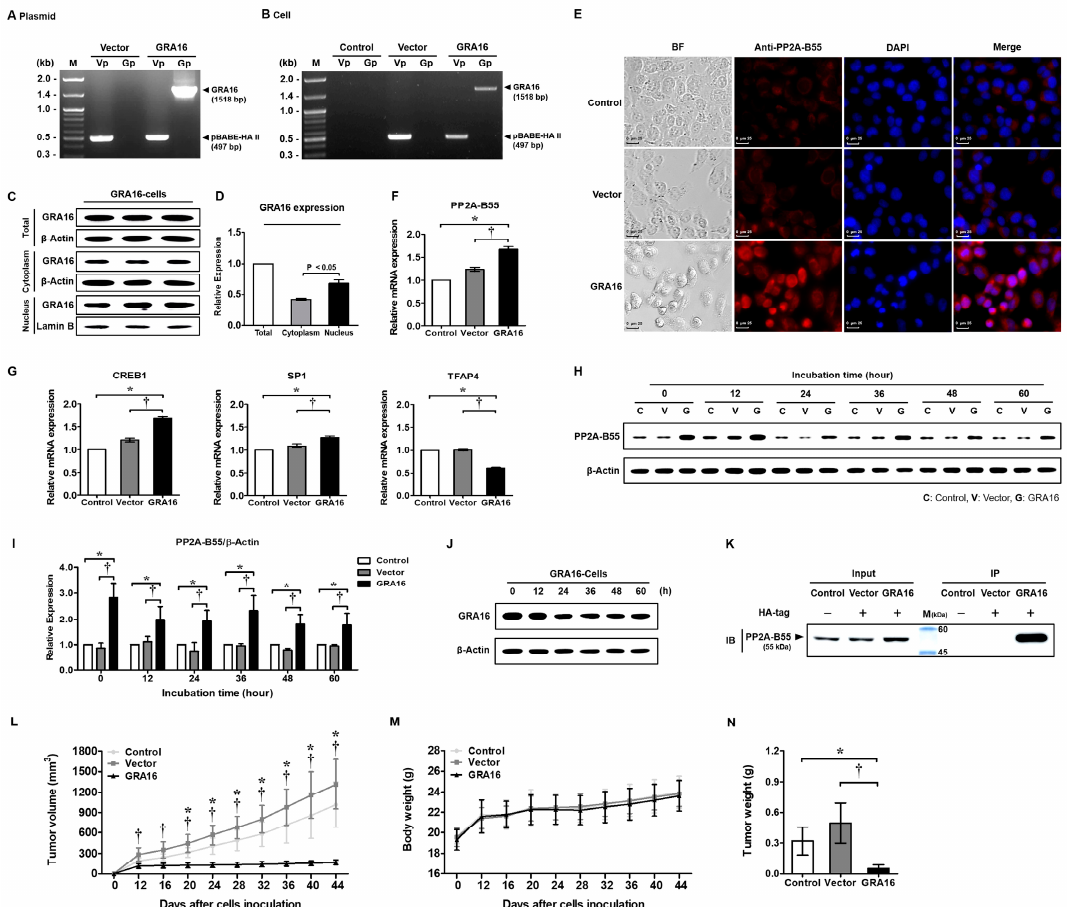
Figure 1. Production of GRA16-stable H1299 cells, binding between GRA16 and PP2A-B55, and anticancer effect in xenograft mice transplanted with GRA16 cells. ( A ) Polymerase chain reaction (PCR) results of the purified pBABE-HA II plasmid (Vector) and GRA16 gene-inserted pBABE-HA II plasmid (GRA16) using primers Vp (vector primer) and Gp (GRA16 primer). ( B ) PCR results of cells (control, vector, and GRA16 cells) using primers (Vp or Gp). ( C ) Western blots showing GRA16 distribution in cell fractions (cytoplasm and nucleus). ( D ) Relative protein expression of HA-tagged GRA16 between the cytoplasm and nucleus. ( E ) Immunofluorescence assay (IFA) for PP2A-B55 expression in control, vector, and GRA16 cells. BF: bright field, DAPI: nucleus staining. Scale bar represents 25 μ m. ( F ) Relative mRNA expression levels of PP2A-B55. ( G ) Gene expression levels of the transcriptional factors ( CREB1 , SP1 , and TFAP4 ) in vector and GRA cells compared with control cells. ( H ) Western blot showing PP2A-B55 expression in control (C), vector (V), and GA16 cells (G) during 60 h after cell synchronization. ( I ) Differences in PP2A-B55 expression among control, vector, and GRA16 cells, with the expression value of control set at “1”. ( J ) Western blots confirming sustained GRA16 expression in GRA16 cells during the 60-h experiment period. ( K ) Co-immunoprecipitation (Co-IP) confirming the interaction between GRA16 and PP2A-B55. Input: immunostaining of PP2A-B55 in total protein before Co-IP analysis; IP: Western blots stained with anti-PP2A-B55 Ab for the protein fraction (GRA16) extracted using anti-HA tag Ab at 48 h of cell incubation. ( L ) Tumor sizes (tumor volumes were calculated as A × B 2 /2 (A: length; B: width)). ( M ) Body weights. ( N ) Tumor weights. * significant at p < 0.05 between control and GRA16 cells; † significant at p < 0.05 between vector and GRA16 cells.